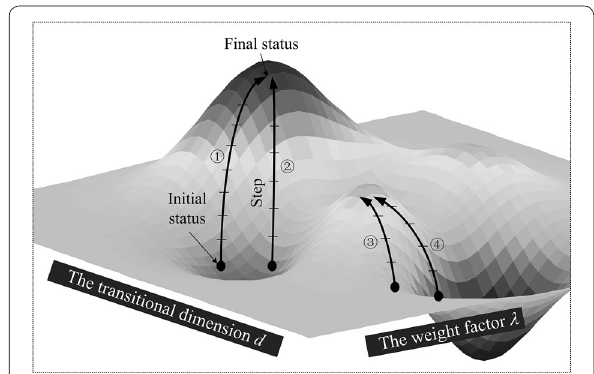
Figure 6 Fundamental of gradient